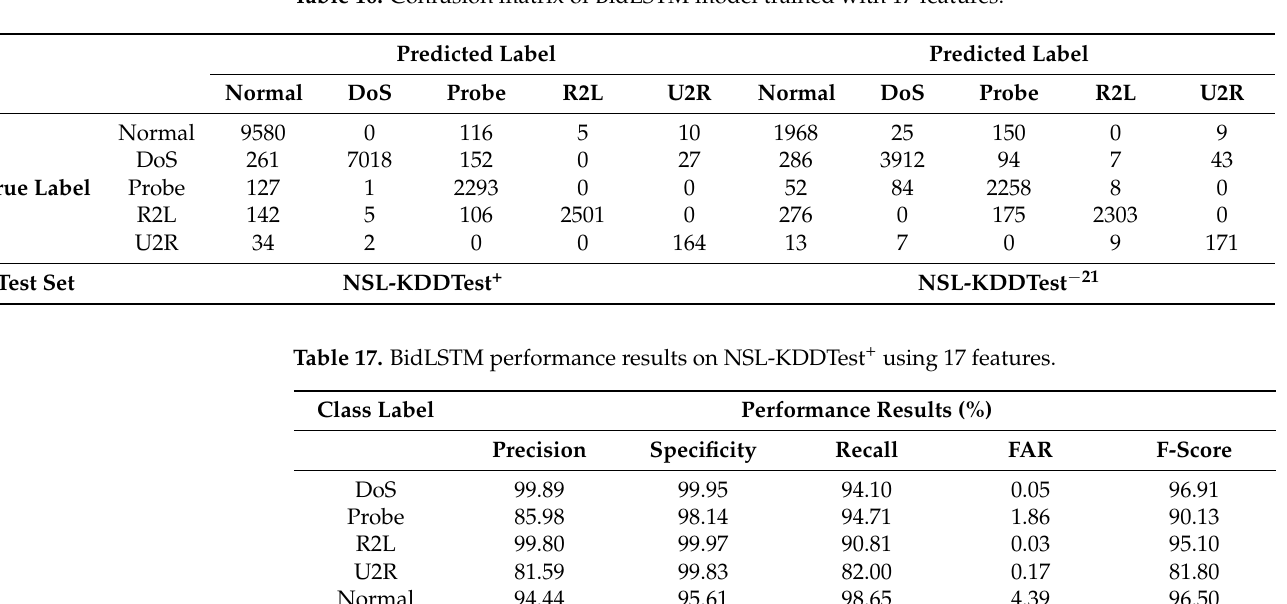
Table 16. Confusion matrix of BidLSTM model trained with 17 features.